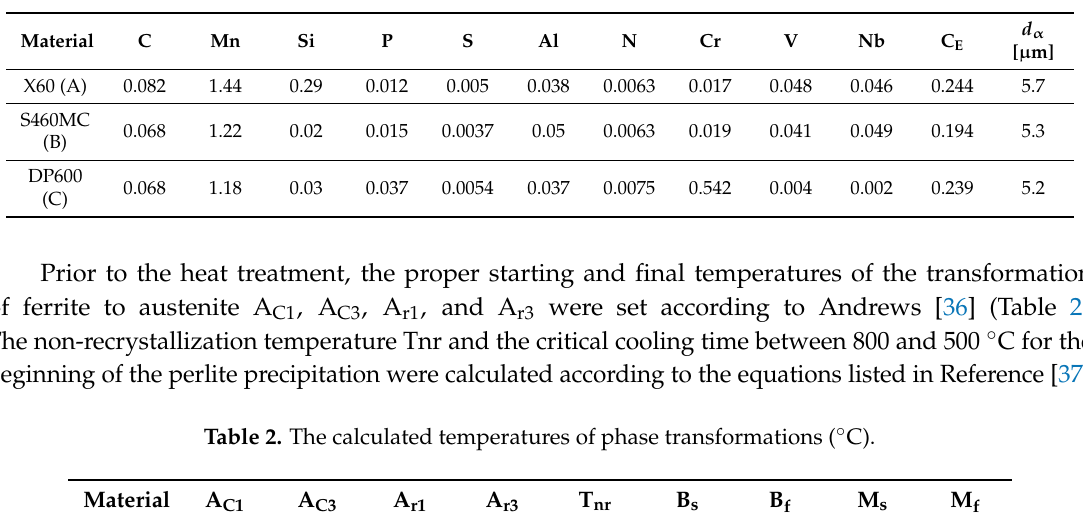
Table 1. The chemical composition of the as-received steels (wt %).